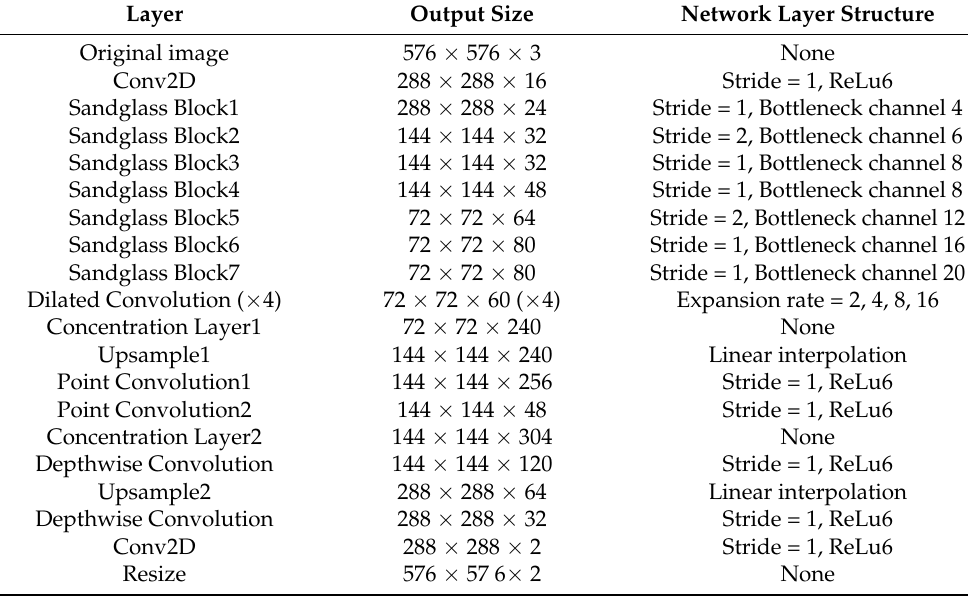
Table 1. The Sandglass-MFN structure parameters.